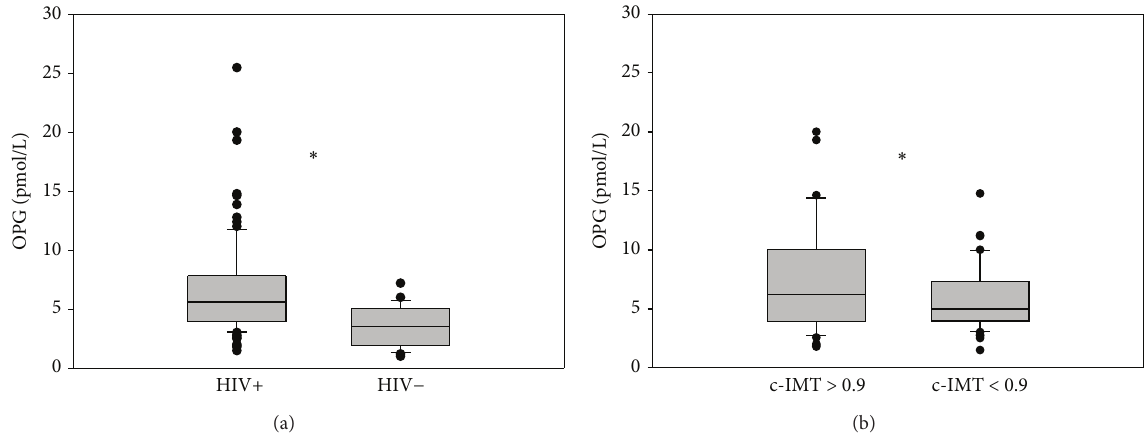
Figure 3: OPG plasma levels in HIV-infected subjects compared with HIV-negative controls (a) and in HIV-infected subjects according to c- IMT (b). Values are expressed as pmol/L. Horizontal bars represent median. Upper and lower whisker mean third quartile +1.5 (interquartile range (IQR)) and first quartile-1.5(IQR). ∗ It represents a 𝑃 value <